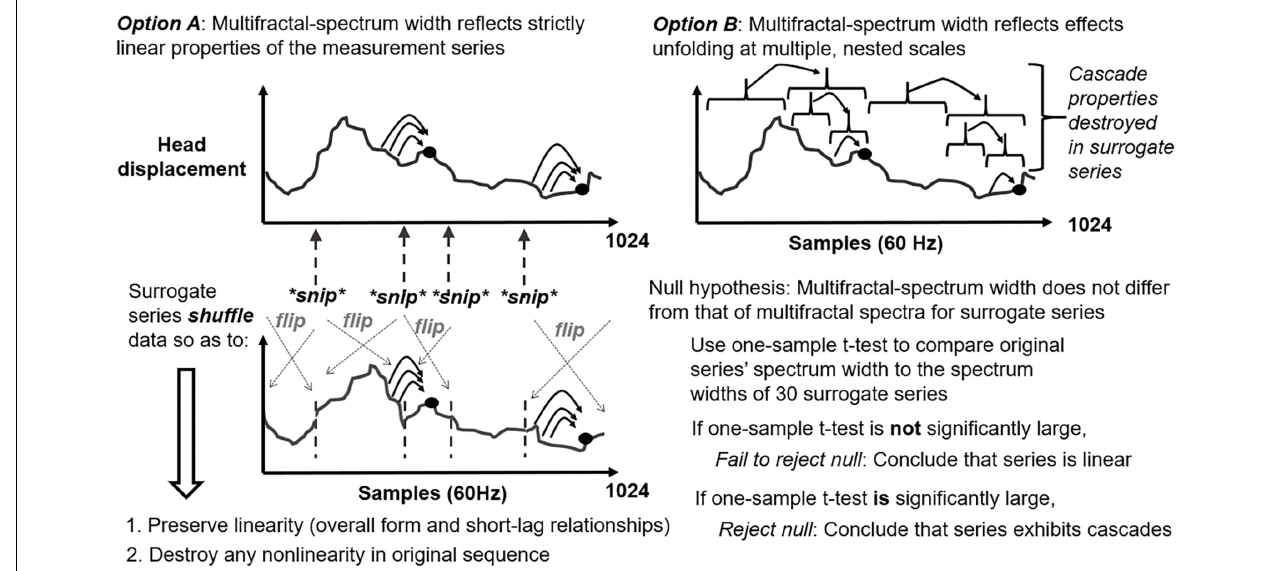
FIGURE 3 | Schematic of iterative amplitude adjusted Fourier transform (IAAFT) surrogate-generation procedure for representing the null hypothesis of linearity (left panel) along with schematic articulation of the alternative hypothesis of non-linearity (right panel) .